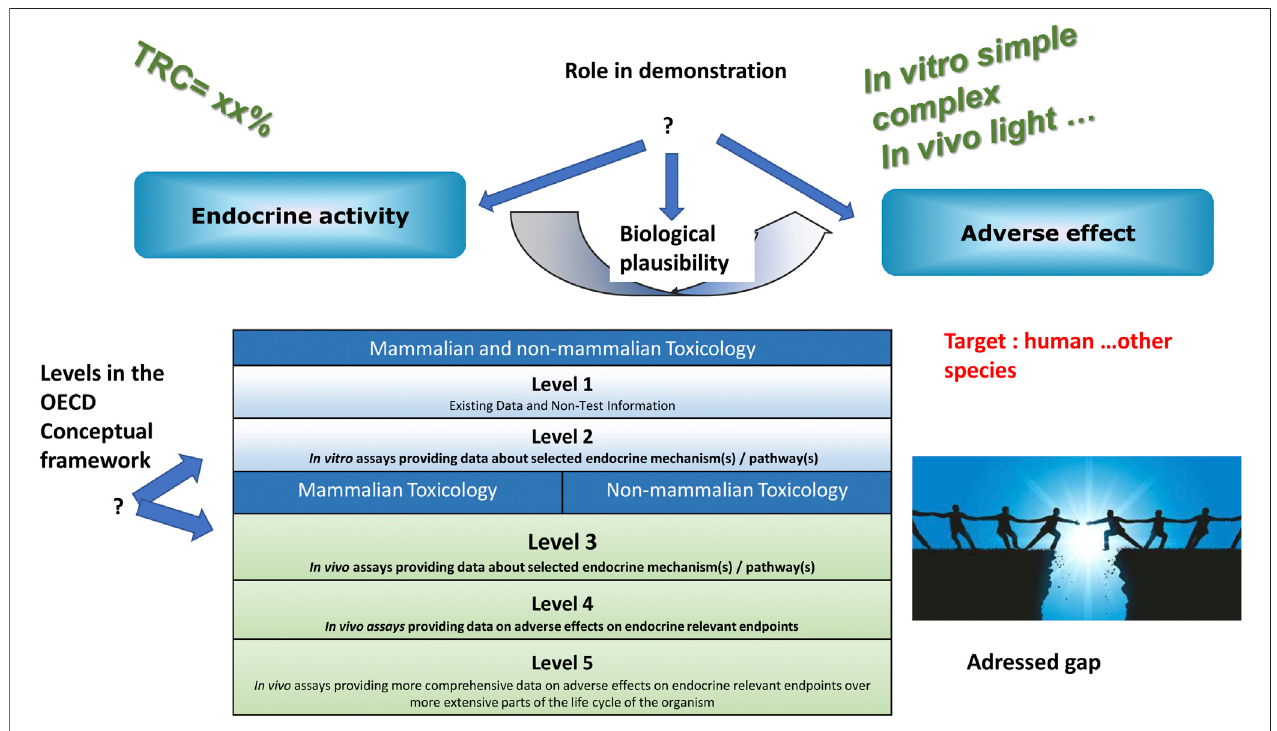
FIGURE 1 | Items for the presentation of